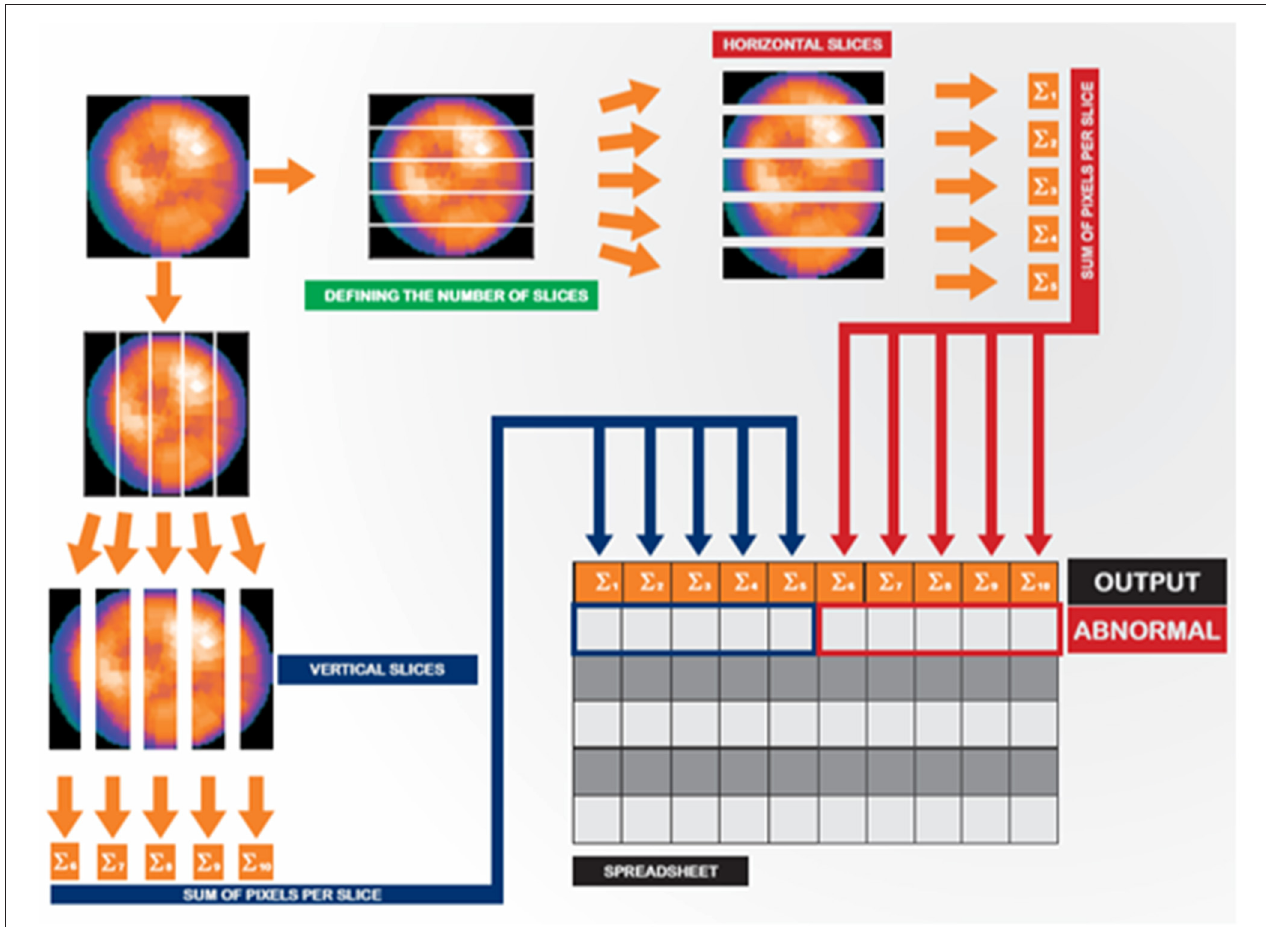
FIGURE 2 | Image slicing and feature extraction